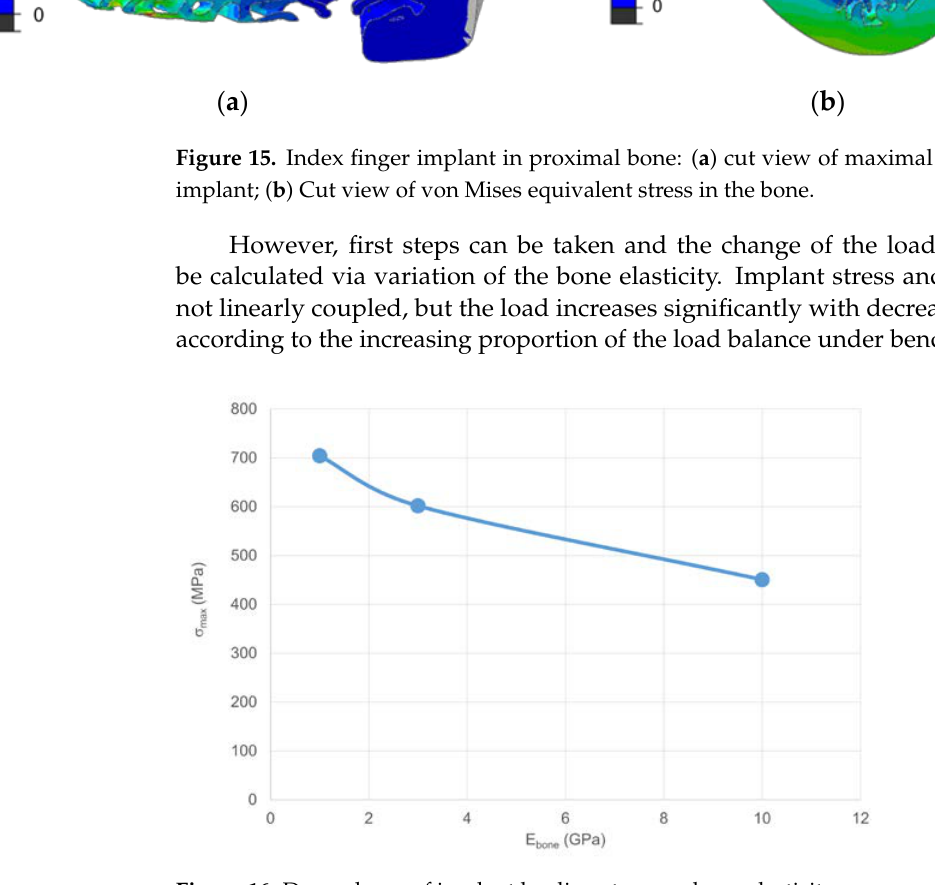
Figure 16. Dependence of implant loading stress on bone elasticity.